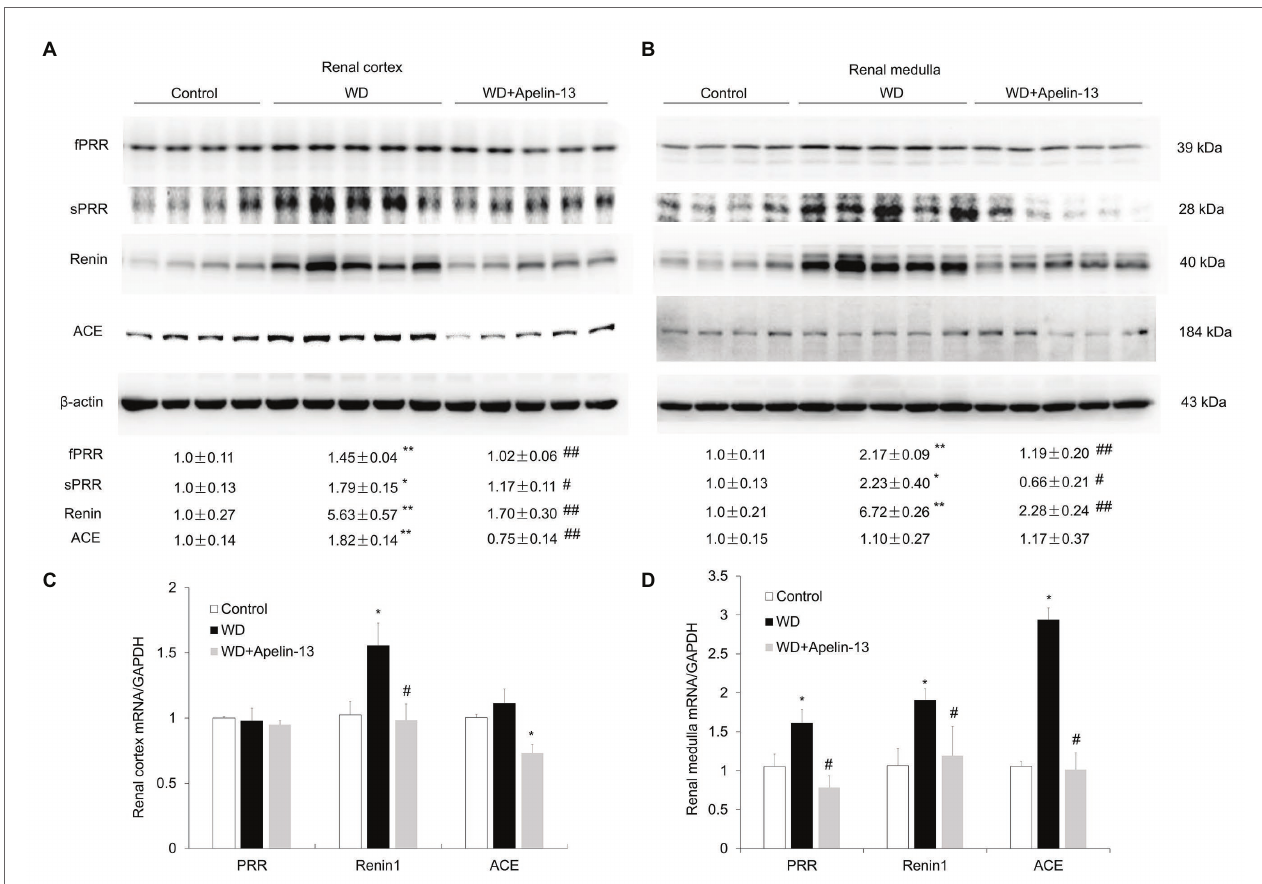
FIGURE 4 | Effect of apelin-13 on intrarenal renin-angiotensin system (RAS) in the renal cortex and medulla in WD mice. (A,B) Representative immunoblotting and densitometric analysis of fPRR, soluble prorenin receptor (sPRR), renin, and ACE protein expression in the kidney cortex (A) and medulla (B) , the protein abundances were normalized by β -actin. (C,D) qRT-PCR analysis of renal PRR , renin 1 , and ACE mRNA expression in the kidney cortex (C) and medulla (D) , expression was normalized by GAPDH . n = 4–5 per group. Data are mean ± SEM. * p < 0.05 and ** p < 0.01 vs. Control; # p < 0.05 and ## p < 0.01 vs.